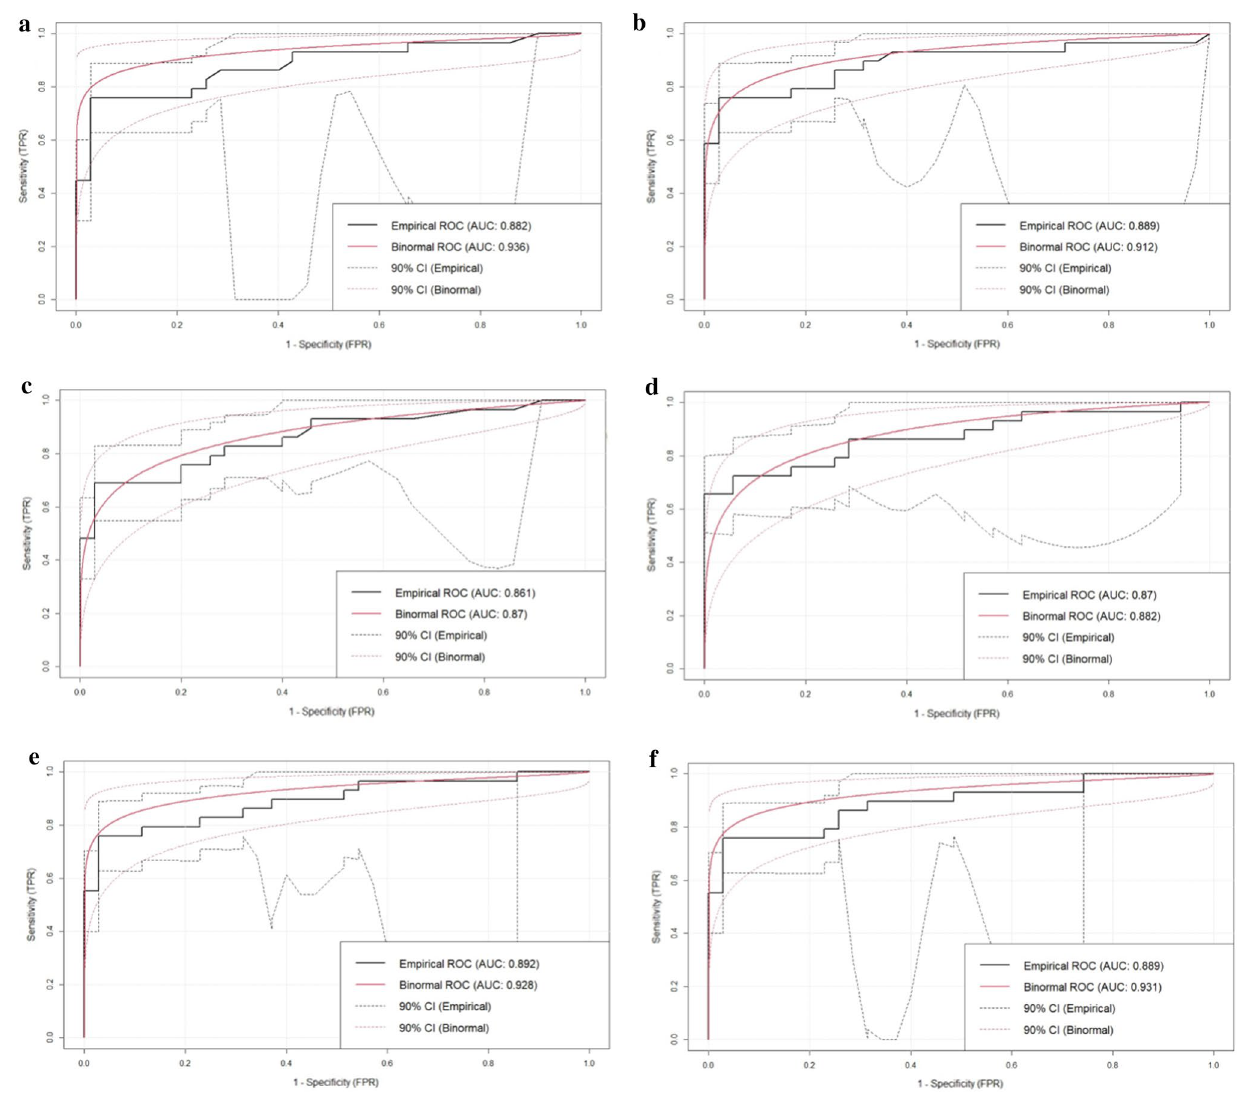
Fig. 6 Validation of GWP models using eROC and bROC curves for a RF, b RS, c bagging, d dagging, e NBT, and f